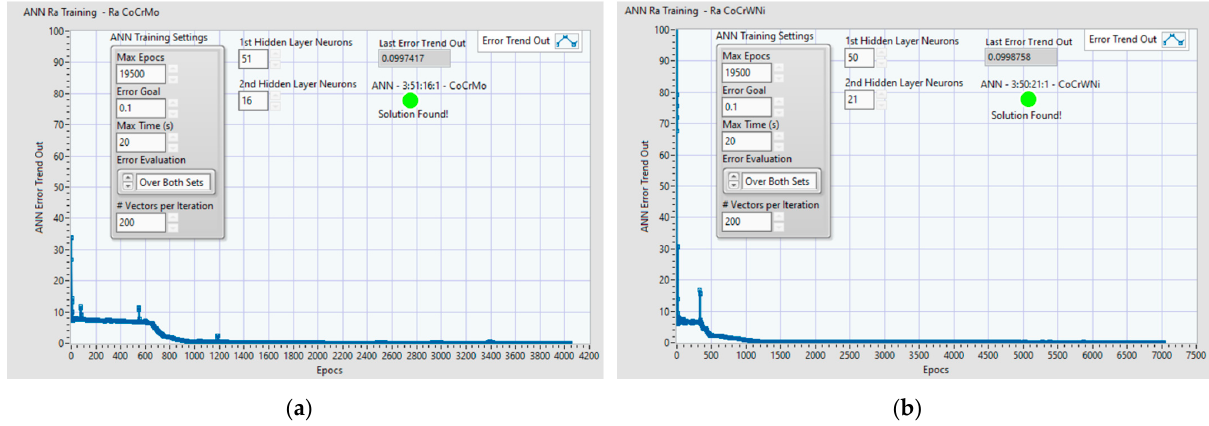
Figure 10. Example of ANN training process: plot of error trend out and other relevant parameters: ( a ) ANN 3:51:16:1 for Co–28Cr–6Mo; ( b ) ANN 3:50:21:1 for Co–20Cr–15W–10Ni.